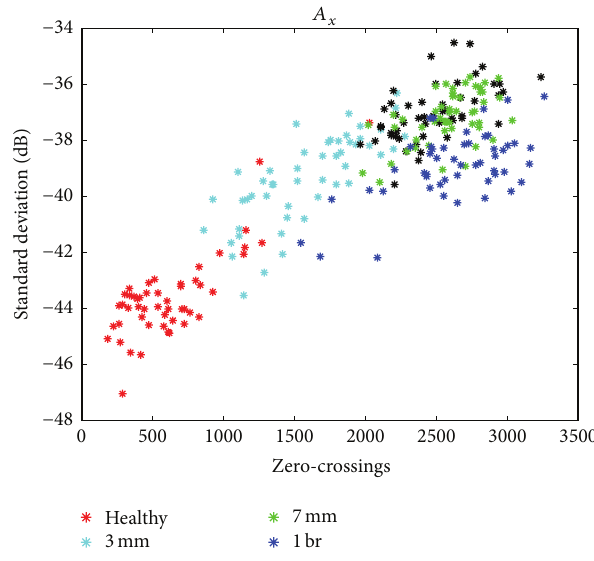
Figure 13: Half-load condition analysis, 𝐴 𝑥